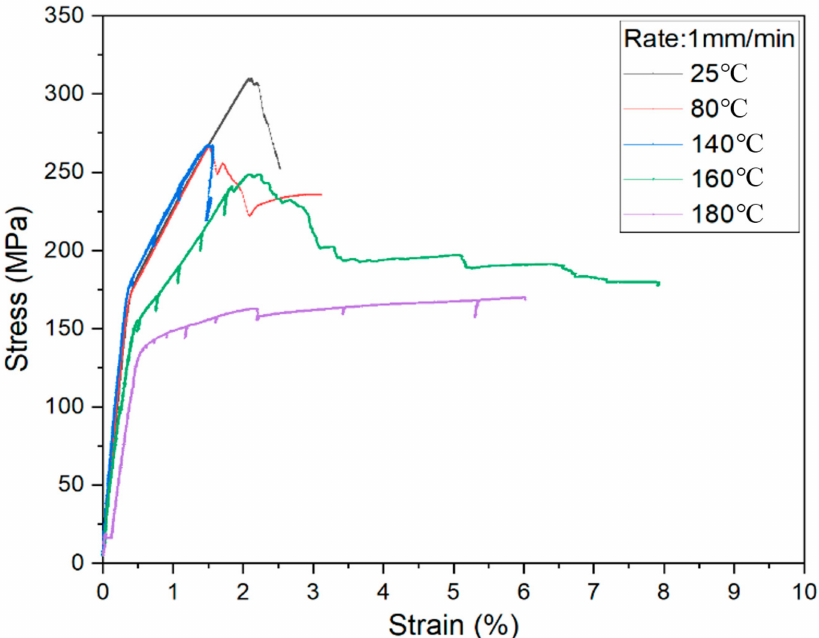
Figure 3. Stress-strain curve under 1 mm/min stretching rate.